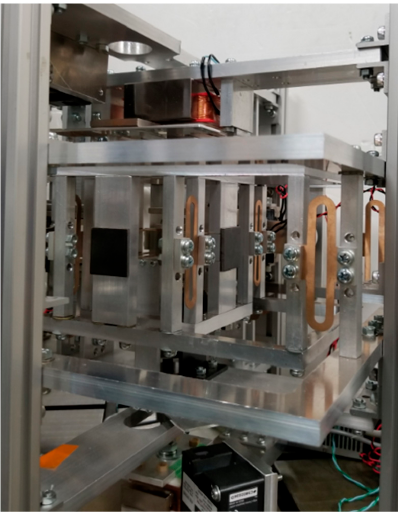
Figure 10. Photograph of the microforce setup.